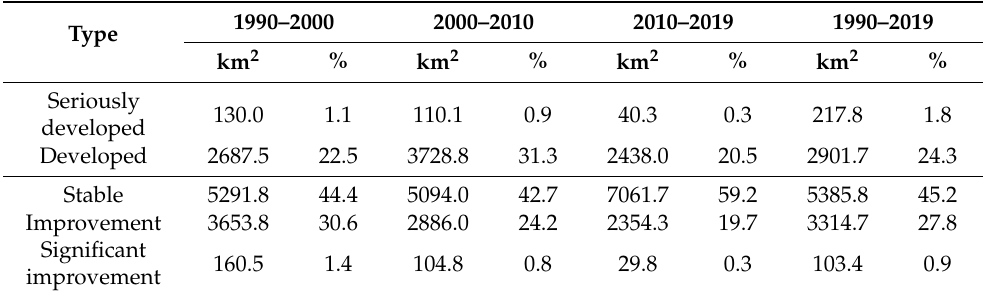
Table 3. Area and proportion of land degradation developed or an improvement of the ADD during different time periods.